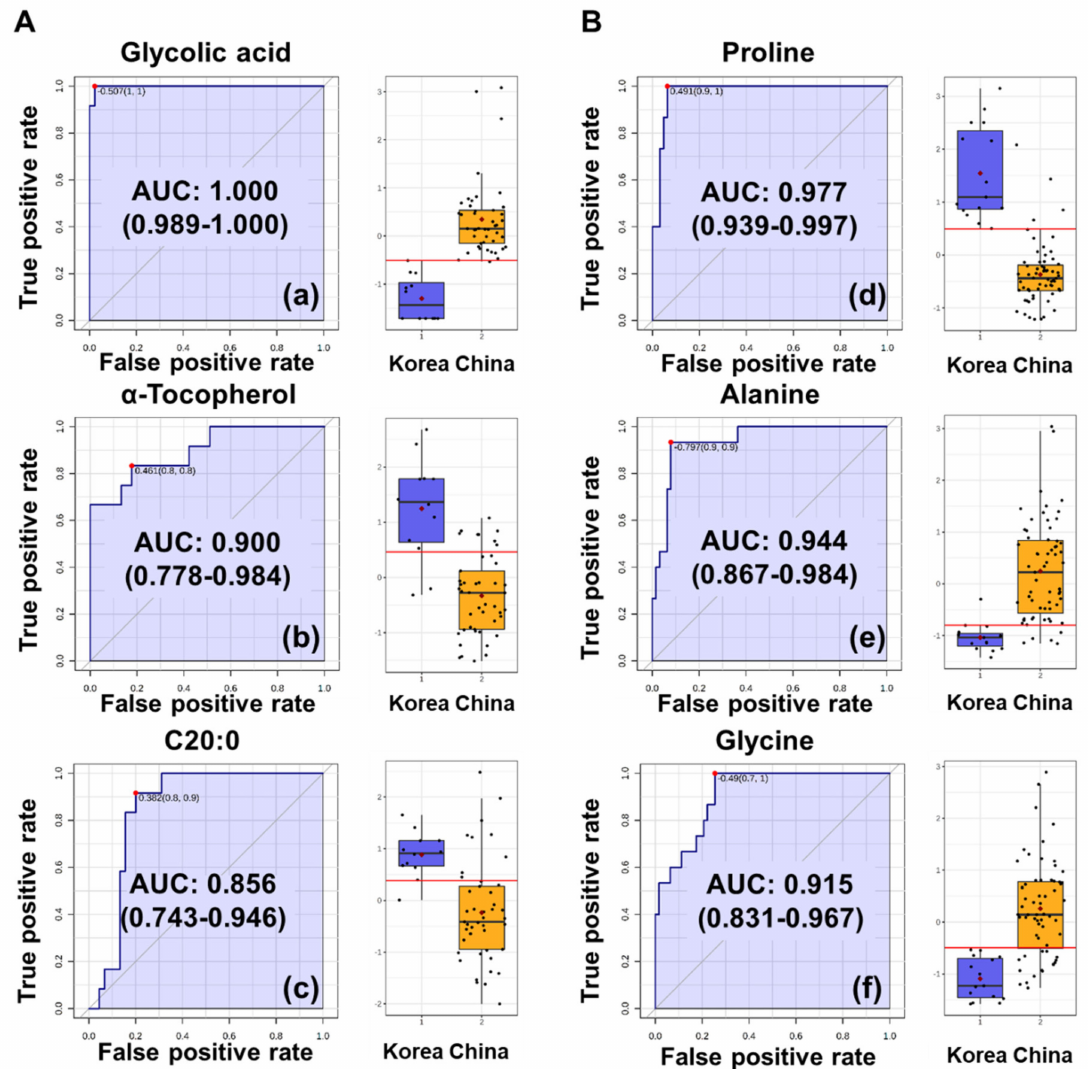
Figure 4. Receiver operating characteristic (ROC) curves for discriminating the geographic origins of ( A ) perilla and ( B ) sesame seeds using metabolite profiling data. ROC curves for (a) glycolic acid, (b) α -tocopherol and (c) C20:0 (arachidic acid) on discriminating ( A ) perilla seeds from Korea and China. ROC curves for (d) proline, (e) alanine and (f) glycine on discriminating ( B ) sesame seeds from Korea and